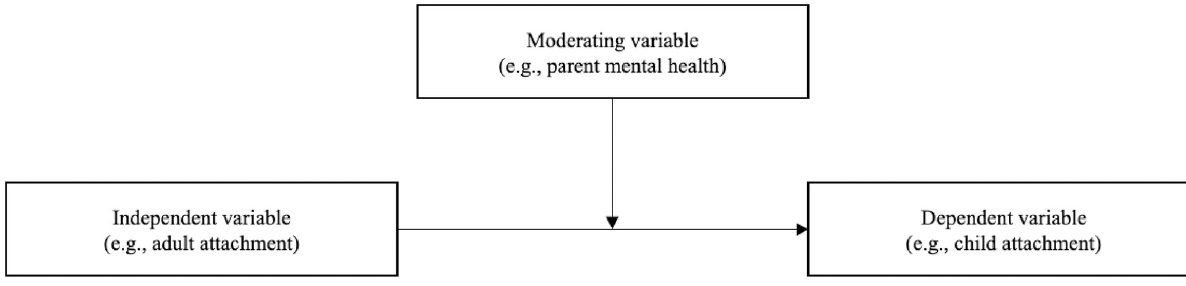
Fig 2. Moderation